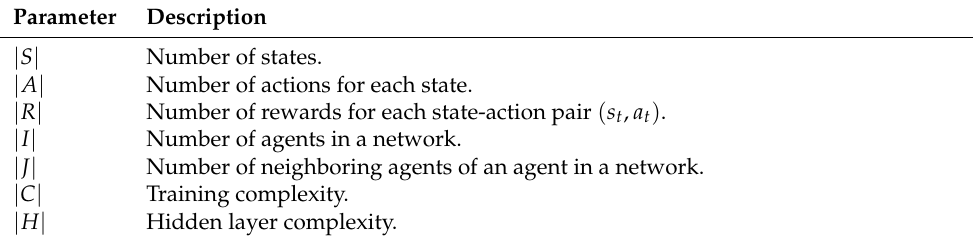
Table 7. Parameters for complexity